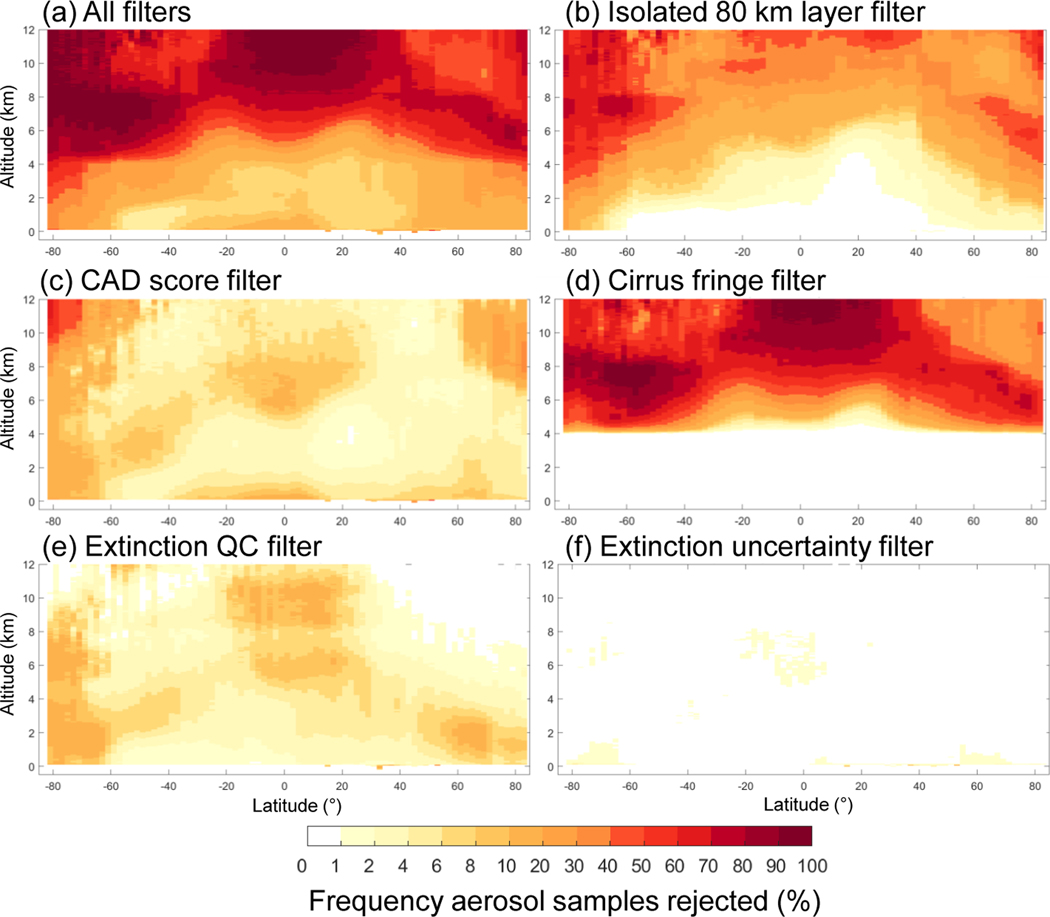
Zonal frequency of aerosol samples rejected by the indicated filter out of all aerosol detected as reported for by the level 3 product for 2007–2016 at night, all-sky.